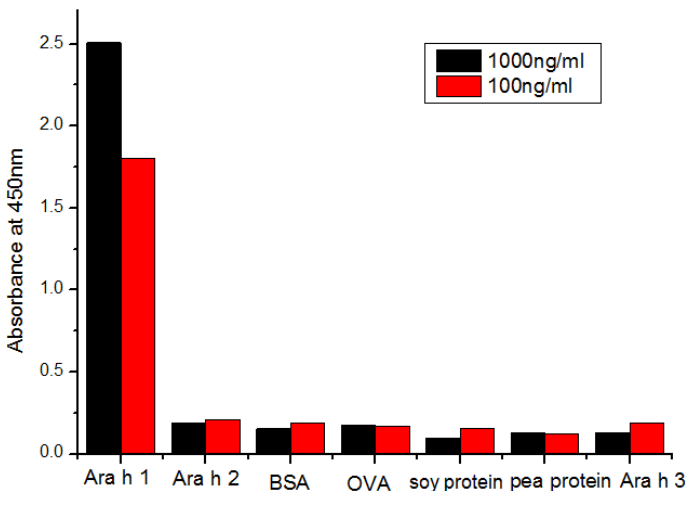
Figure 3. The cross-reactivity determination results with the similar